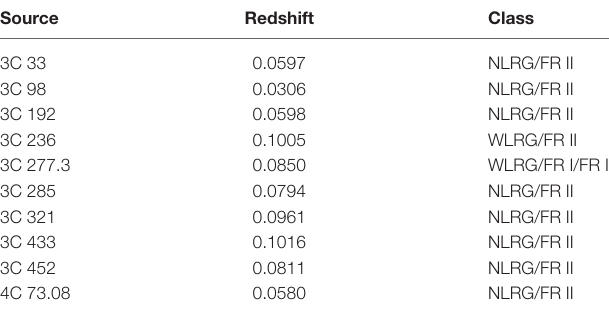
TABLE 1 | The analyzed sample. Source Redshift